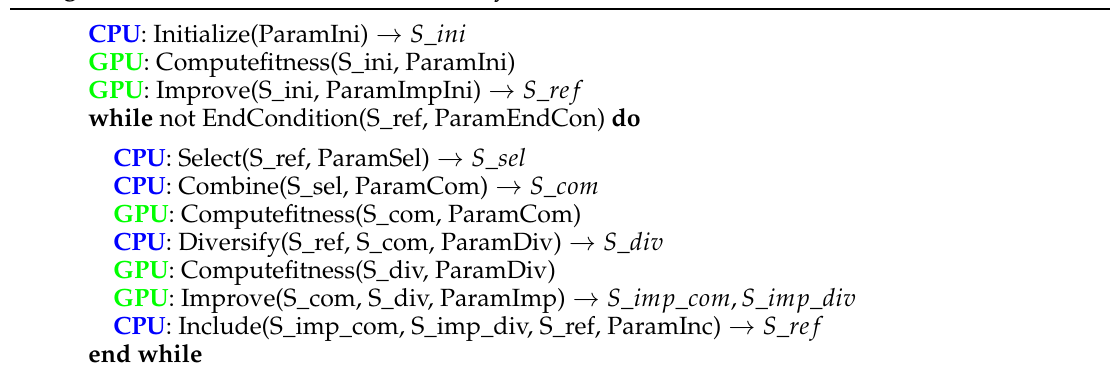
Algorithm 2: Parameterized schema for hybrid metaheuristics. CPU/GPU work